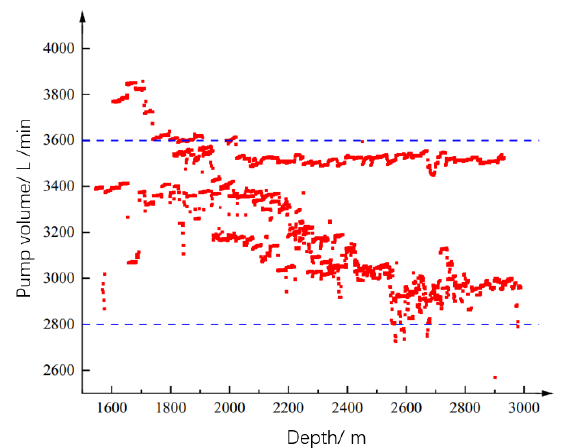
Figure 6. Pump volume as function of depth.